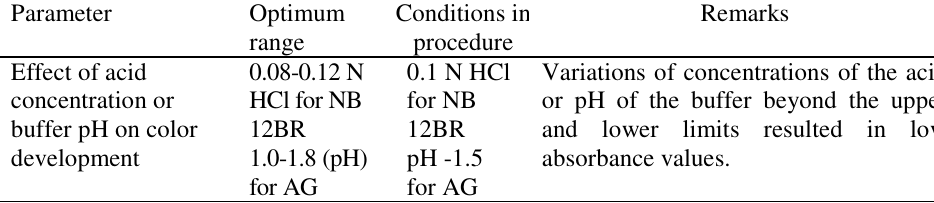
Table 2. Optimum conditions established for NB 12BR and